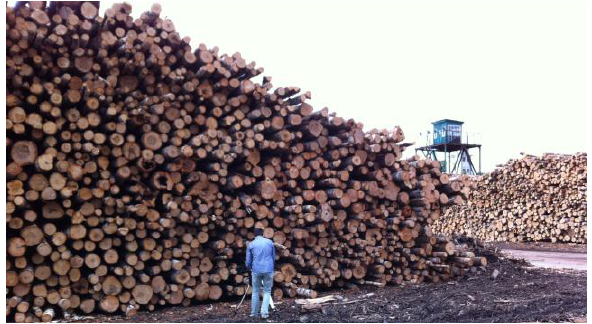
Figure 1. Seaport timber